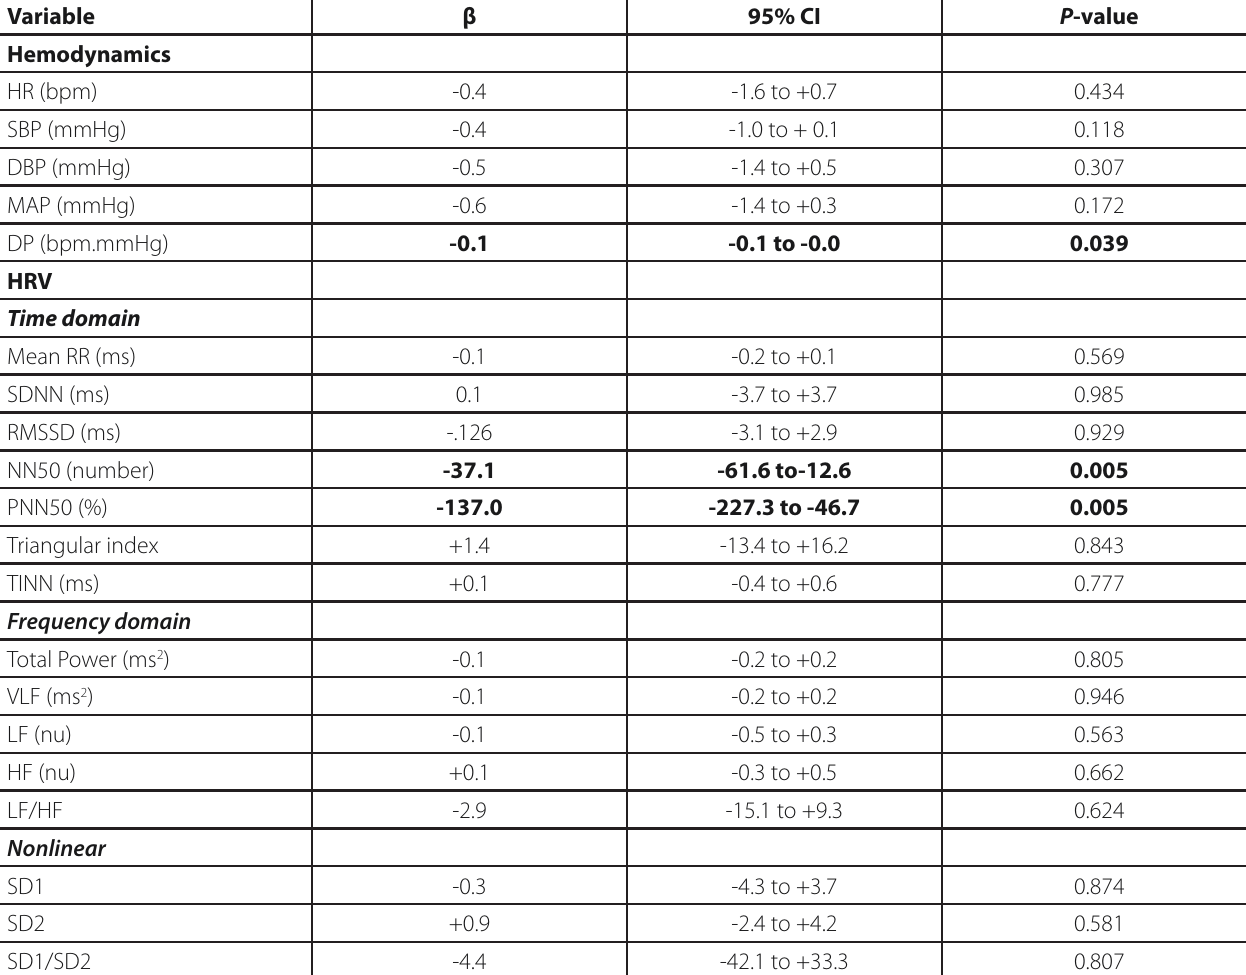
Table 4. Associations of hemodynamics and heart rate variability variables with SF-36 total score. Variable β 95%